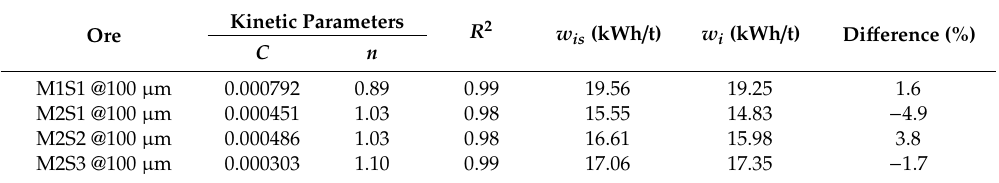
Table 2. Comparison between Work Indexes for metal ores and reference mesh of 100 µ m, obtained through the standard procedure and the simulation ( w i = Work Index; w is = simulated Work